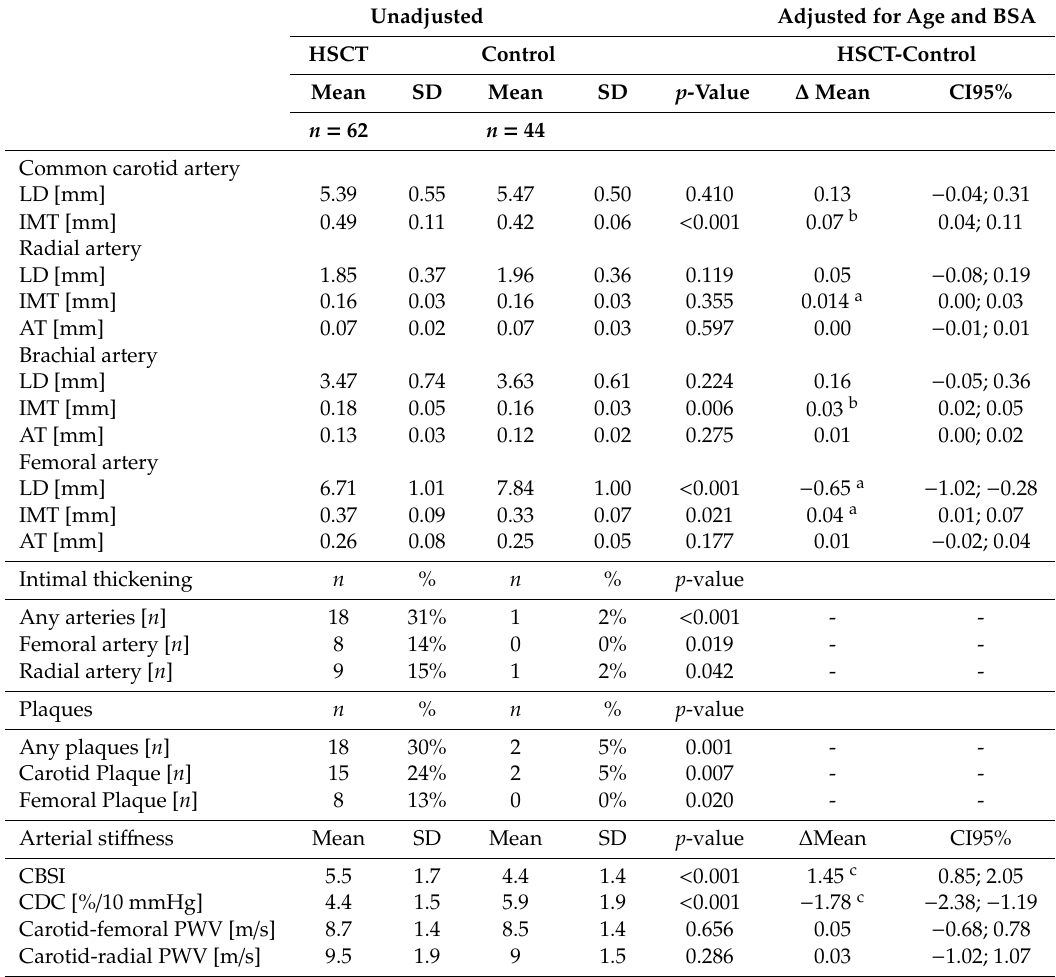
Figure 2. Scatter plots of (A) linear regressions (CI 95% shaded area) of carotid intima-media thickness (CIMT) increase with age among HSCT and controls showing the significant increase in the age-related increase of CIMT in HSCT patients compared to controls. Table 2. Comparison of vascular parameters between HSCT and